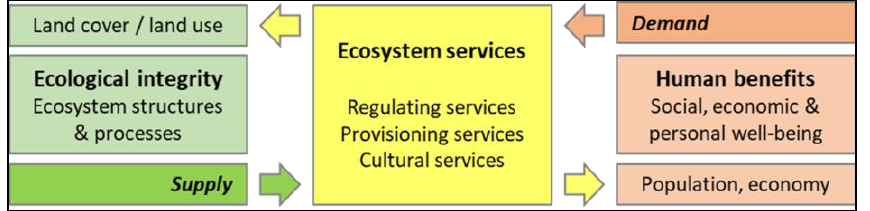
Figure 1. Interaction of ecosystem structures and processes (supply side) as well as ecosystem services and human well-being (demand side) [15] (p. 19, with alterations).